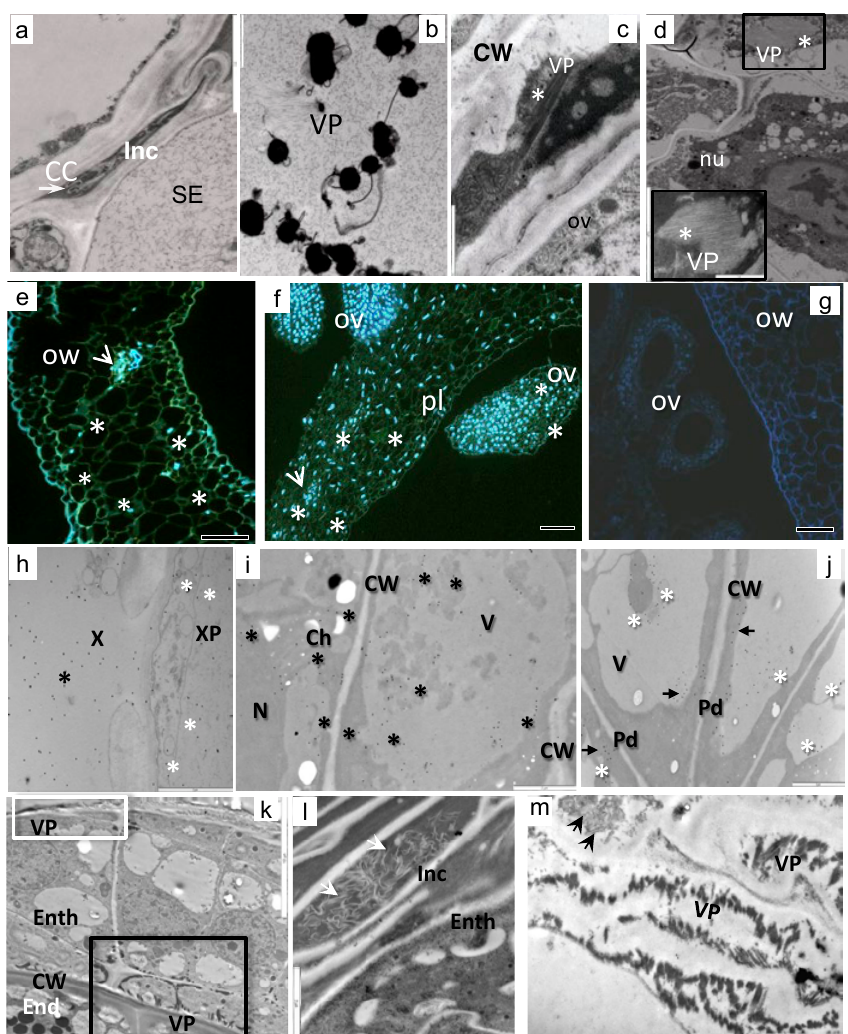
Figure 1. Ultrastructural analysis (a-d) with PVY NTN immunolocalization (e-j) of infected Capsicum annuum ovary (a-j) and analysis of C. annuum seeds (k-m). a) PVY NTN cytoplasmic inclusions (Inc, arrow) in necrotic and collapsed